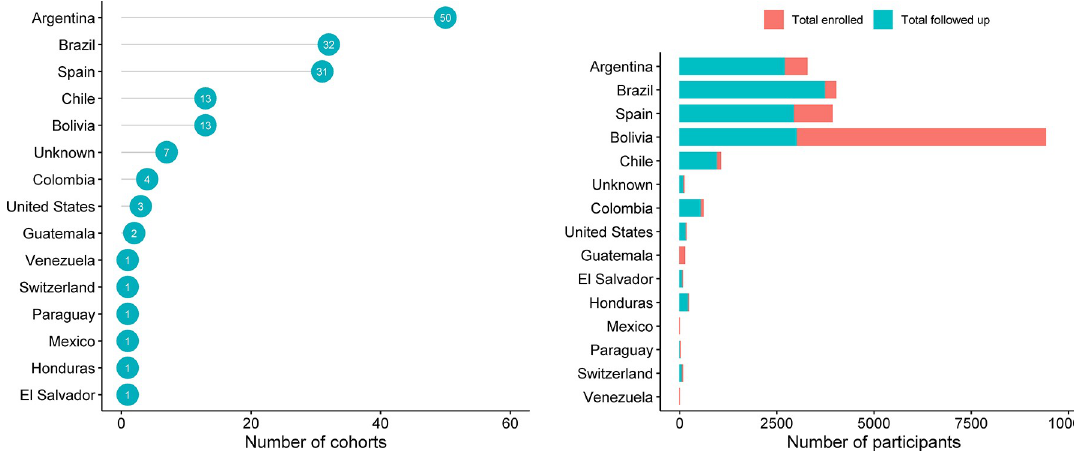
Fig 4. Number of cohorts and participants size stratified by